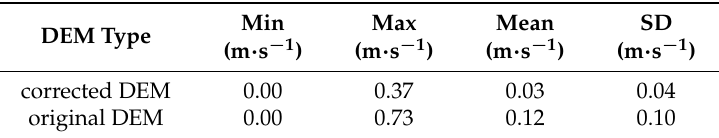
Figure 12. Relations between the velocity values obtained from the 2D model for the reference DEM and ( a ) corrected DEM and ( b ) original DEM. Variants for the flow rate equal to 279.1 m 3 ·s − 1 . Table 3. Velocity differences between reference DEM based on LIDAR data and corrected and original DEMs for a flow rate Q = 279.1 m 3 ·s − 1 .